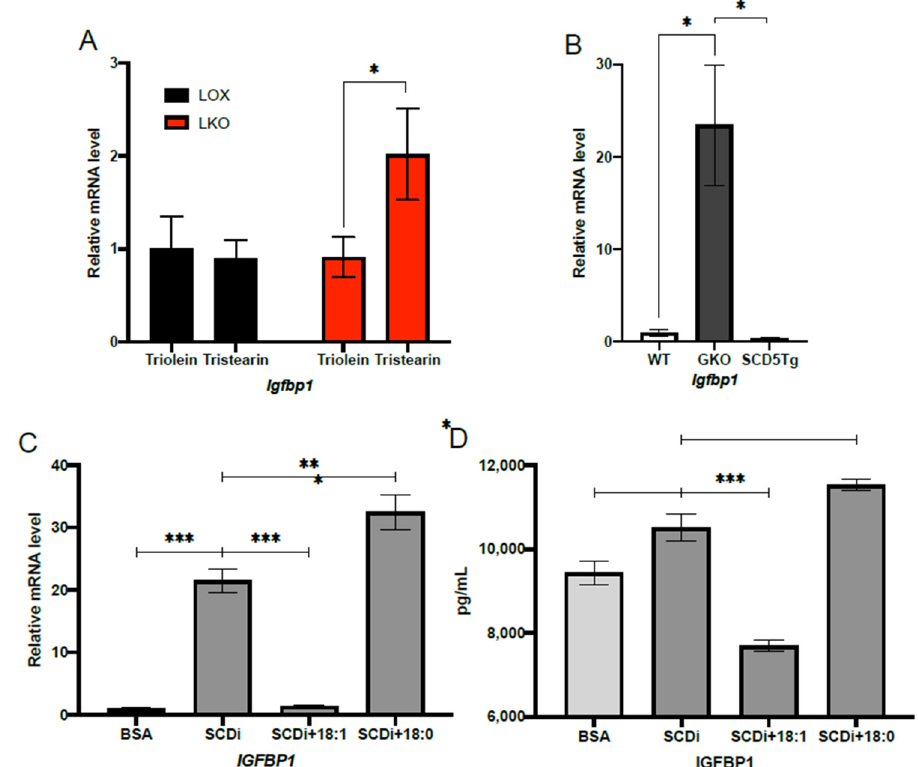
Figure 2. Oleic acid blunts IGFBP1 up-regulation in vivo and in vitro. ( A ) Relative hepatic Igfbp1 mRNA levels in 12–14 weeks old male LOX and LKO mice fed either HCD supplemented with 15% by weight tristearin (n = 4 LOX and n = 4 LKO) or 15% by weight triolein (n = 5 LOX; 7 LKO) for 10 days. ( B ) Relative hepatic Igfbp1 mRNA levels in 8–10 weeks old male WT (n = 4), GKO (n = 6), and SCD5tg (n = 5) mice fed HCD for 10 days. ( C ) Relative Igfbp1 mRNA level in HepG2 cells treated for 24 h with either BSA (n = 10), BSA plus 4 μ M SCD inhibitor (n = 12), BSA plus 4 μ M SCD inhibitor, and 500 μ M oleic acid (n = 12), or BSA plus SCD inhibitor and 500 μ M steric acid (n = 12). ( D ) Secreted IGFBP1 protein concentration in HepG2 cells treated for 24 h with either BSA (n = 7), BSA plus 4 μ M SCD inhibitor (n = 8), BSA plus 4 μ M SCD inhibitor and 500 μ M oleic acid (n = 7), or BSA plus SCD inhibitor and 500 μ M steric acid (n = 8). Values are mean ± SEM; * p < 0.05 vs. WT, LOX, or BSA; ** p < 0.01 vs. WT, LOX, or BSA; *** p < 0.005 vs. WT, LOX triolein or BSA by Student ′ s two-tailed t -test.